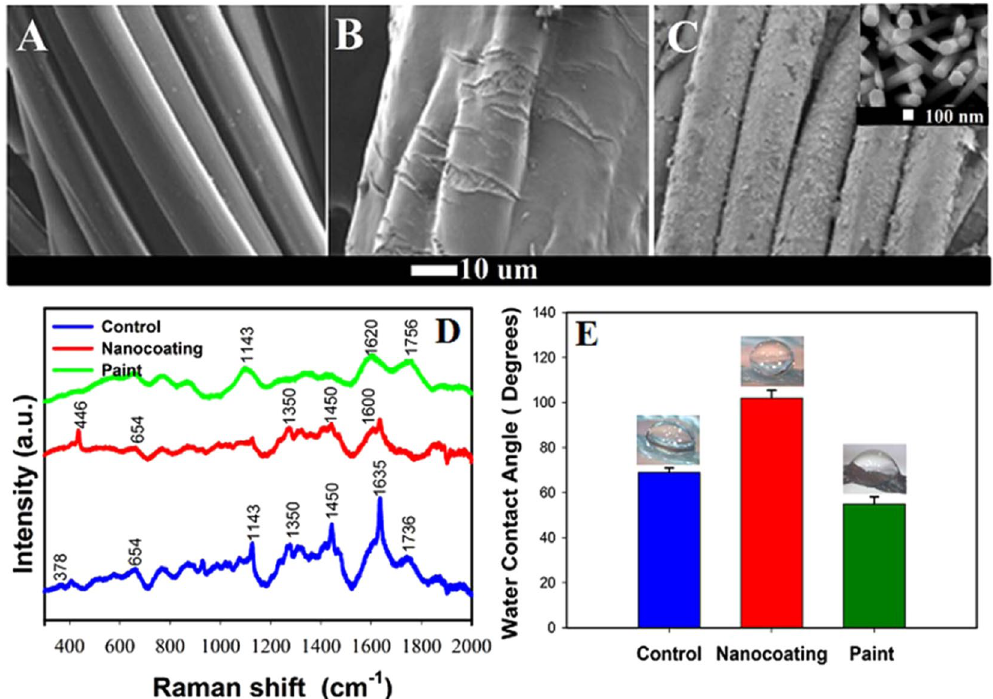
Figure 1. Morphology, wetting and Raman spectroscopy of coatings. Scanning electron micrographs of ( A ) Single fibre of control nylon 6 net. ( B ) Single fibre of nylon 6 net after coating with AF paint. ( C ) Single fibre of nylon 6 net after coating with ZnO nanorods. ( D ) Raman spectra for control, AF painted and nanocoated nylon 6 net substrate. ( E ) Water contact angle measurement for control, AF painted and nanocoated net